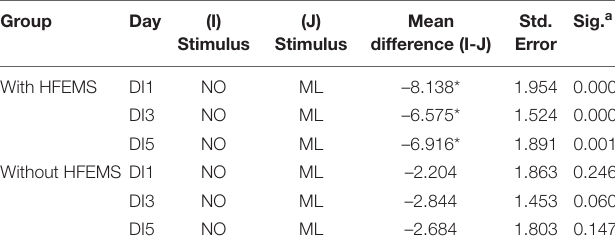
TABLE 1 | The strength of the Müller-Lyer illusion in comparison with neutral segments.